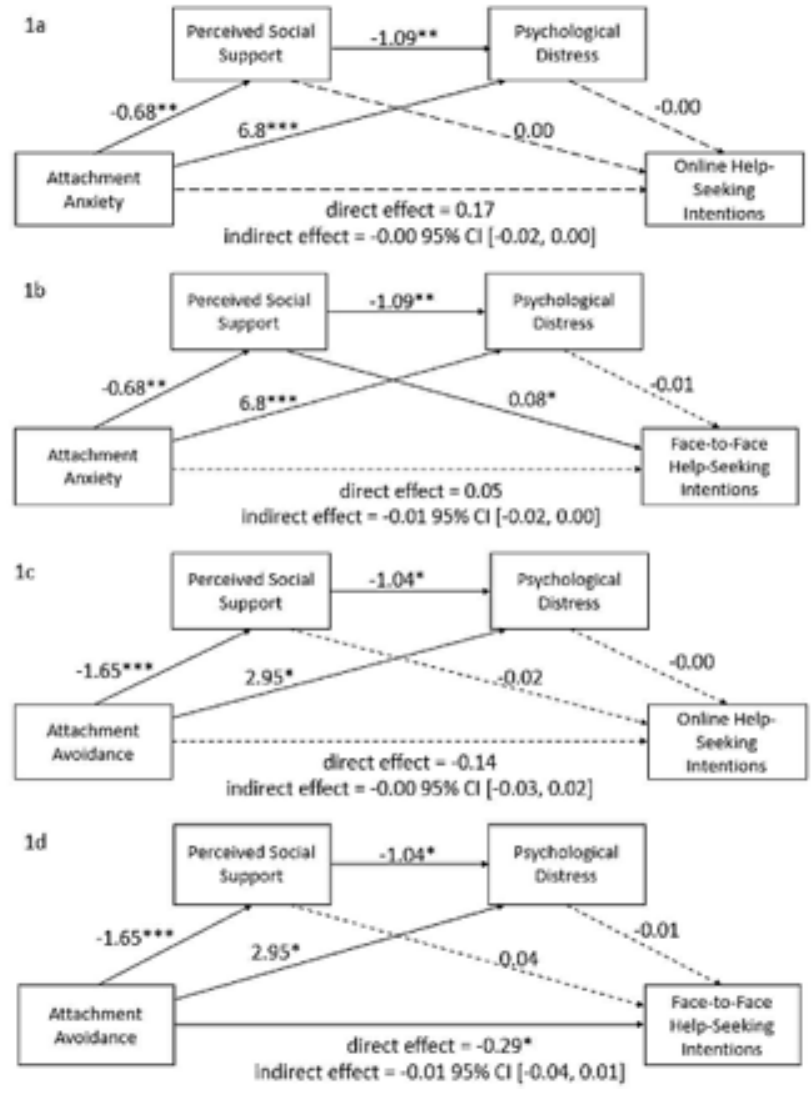
Figure 1 . Multiple Mediation Analyses: The relationship between attachment anxiety and online help-seeking intentions (Figure 1a), the relationship between attachment anxiety and face-to-face help-seeking intentions (Figure 1b), the relationship between attachment avoidance and online help-seeking intentions (Figure 1c), and the relationship between attachment avoidance and face-to-face help-seeking intentions (Figure 1d), all mediated by perceived social support and psychological distress. N = 301 respondents; *P < .05, **P < .01, ***P < .001. Unstandardized coefficients are reported. Dotted lines indicate non-significant coefficients, P >